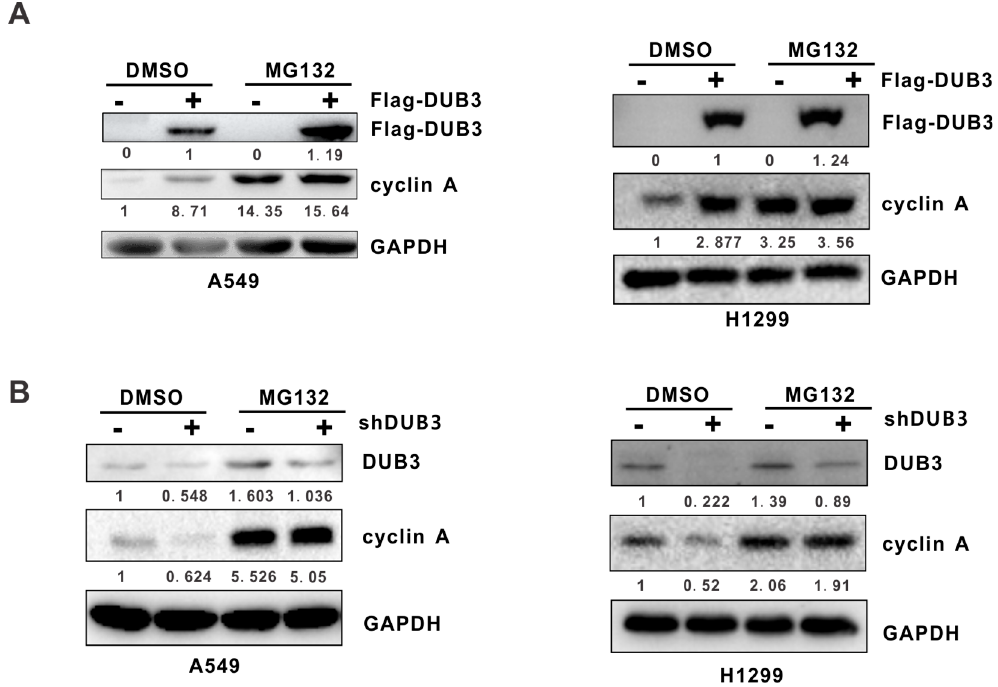
Figure 2. DUB3 regulates cyclin A levels via the proteasome pathway. ( A ) A549 and H1299 cells transfected with Flag-DUB3 plasmid or the control plasmid were treated with DMSO or MG132 (20 µ M) for 6 h. Expression of the indicated proteins were examined by Western blotting using the indicated antibodies. ( B ) A549 and H1299 cells infected with the indicated lentiviral shRNAs were treated with DMSO or MG132 (20 µ M) for 6 h, and the indicated proteins were analyzed by Western blotting.